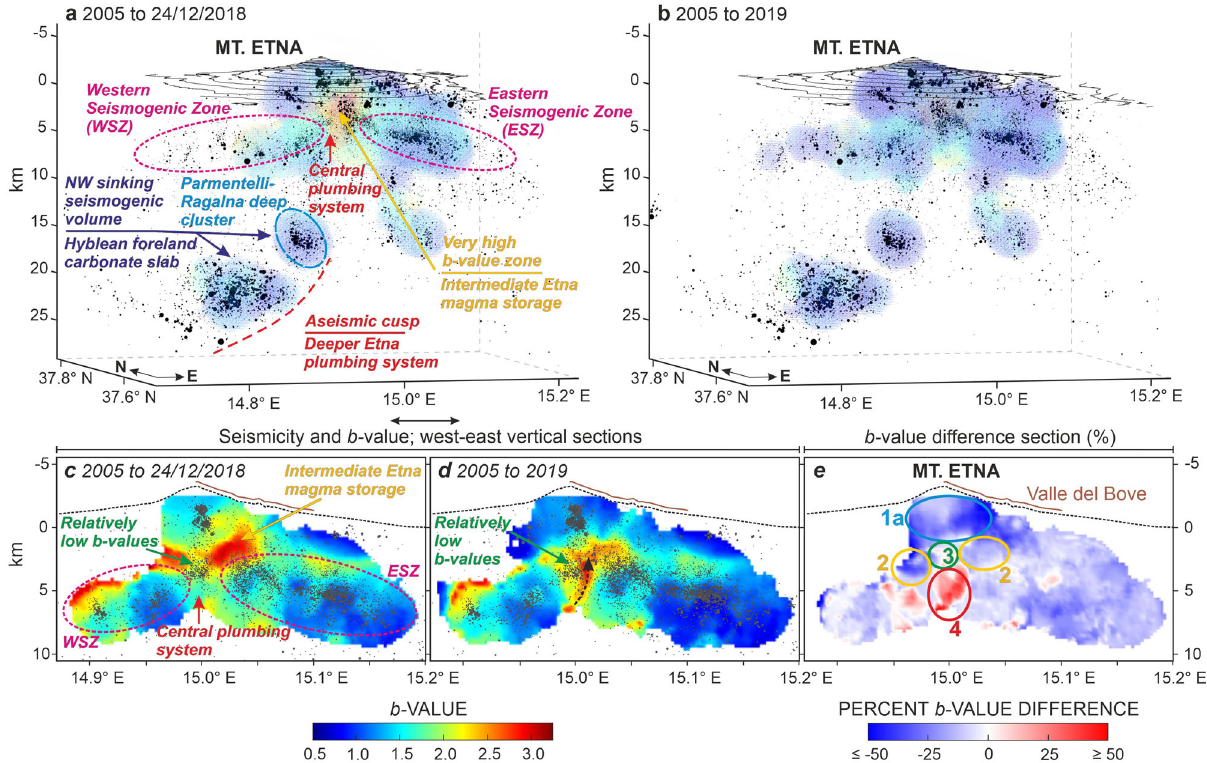
Fig. 3 Volumetric view and sections of seismicity and b -values in the Etna region from 2005 to 2019. a Prospective volumetric view from the southwest of seismicity and related b -values between 2005 and 24 December 2018, just before the major intrusive episode. b Same prospective volumetric view of seismicity and related b -values of the entire 2005 – 2019 Etna seismic catalogue. c West-East vertical section at lat. 37.75°N of b -values and seismicity within a buffer of 3 km from the plane, which contains only those earthquakes that may have in fl uenced b computing between 2005 and 24 December 2018. d Same as c , but over the entire 2005 – 2019 time-interval. e Percent b -value difference section between ( d ) and ( c ); 1a, 2, 3 and 4 are regions of particular interest (see text for details). Earthquake foci are represented by dark dots, whose dimension is plotted as a function of M L . Sections derive from spline interpolation between the nodes of the three-dimensional grid spaced 250 m, shown in ( a , b ). The b -value colorbar at the bottom of the fi gure refers to both the b -values shown as coloured dots in the prospective volumetric views ( a , b ) and to the vertical sections ( c , d